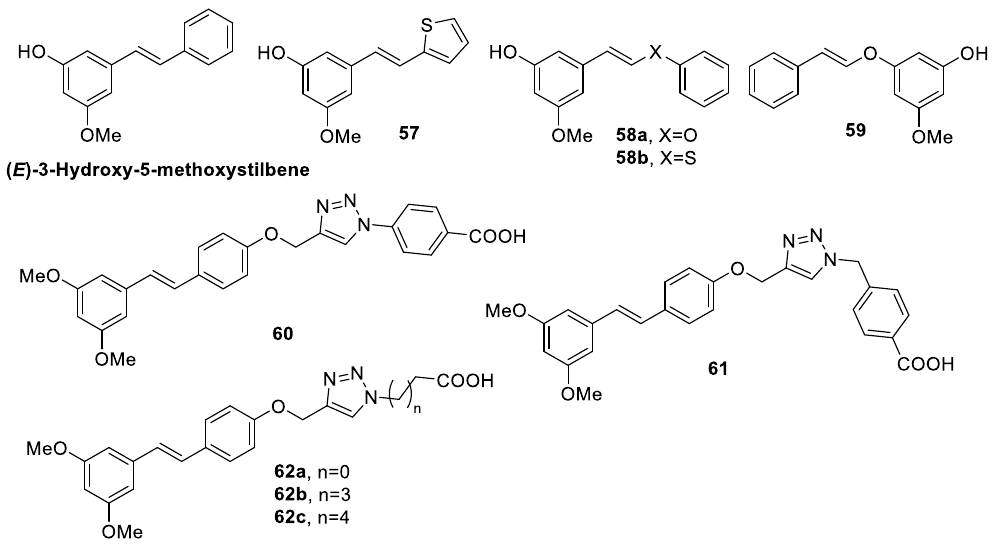
Figure 15. (E)-3-Hydroxy-5-methoxystilbene and synthetic analogues from Kabir et al. (2008) [96] and from Tang et al. (2019) [97].